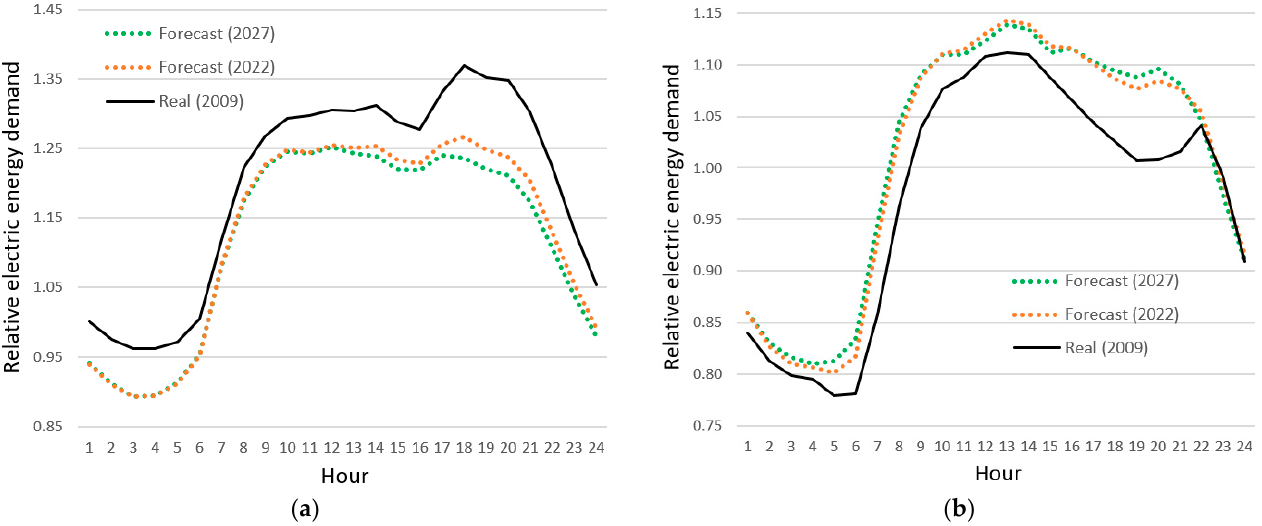
Figure 15. ( a ) Forecast relative profiles of power demand for the winter typical day; ( b ) Forecast relative profiles of power demand for the summer typical day.